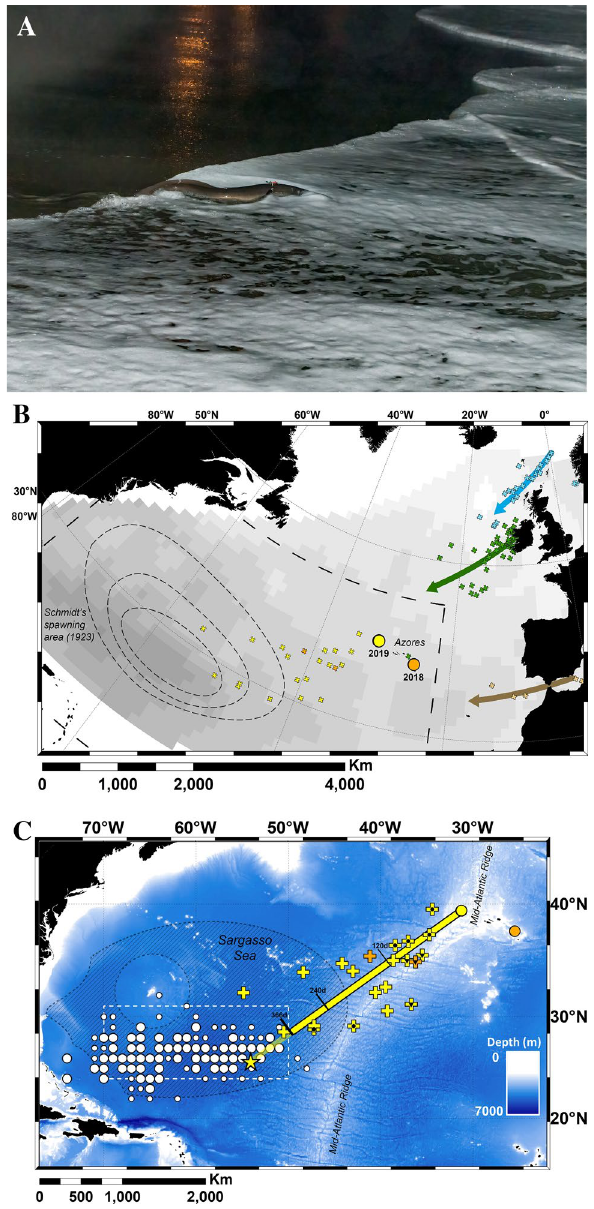
Figure 1. Migration of European eels from the Azores to the Sargasso Sea spawning area. ( A ) European eel fitted with a pop-up satellite tag; ( B ) historic data, showing the location of the proposed spawning area 1 in relation to previous pop-up satellite tag positions (crosses) from eels released from three different locations in Europe 20 . Shading shows kriged minimum leptocephalus size data from ICES in a 1° grid; ( C ) pop-up data from European eels tagged at two Azores locations (circles) in November of 2018 (gold) or 2019 (yellow). Symbols within the crosses show if the tags detached from the eels prematurely, either due to exceeding the depth failsafe of 1400 m (downward triangle), or for other (unknown) reasons (circle). Predations are not shown. The average bearing of eels released in 2019 is shown as a yellow line, with intervals along the line marking the distance travelled at the average speed shown by eels at liberty for 120 day or less, at liberty for between 120 and 240 day, and at liberty for > 240 day. The yellow star shows the extrapolated position along the average bearing for a migratory period ending at the second peak spawning event after release (i.e. 14th February 20,22 , 466 day after release). White circles (at 1° grid) show where the smallest larval eels have been recorded in larval surveys conducted over the last century (large circles = larvae < 8 mm, small circles = larvae 8 mm to 12 mm), while the white dotted line shows the boundary extent of the spawning area in recent times, as presented in Miller et al . 6 . The hatched area shows the area defined as the Sargasso Sea Area of Collaboration 23 . The bathymetry used in the ( B ) and ( C ) is the GEBCO grid (GEBCO Compilation Group, 2020) 24 , and both figures were drawn in ESRI ArcMap 10.5, available to download at the ESRI website (https:// suppo rt. esri. com/ en/ Produ cts/ Deskt op/ arcgis- deskt op/ arcmap/ 10-8- 2# downl